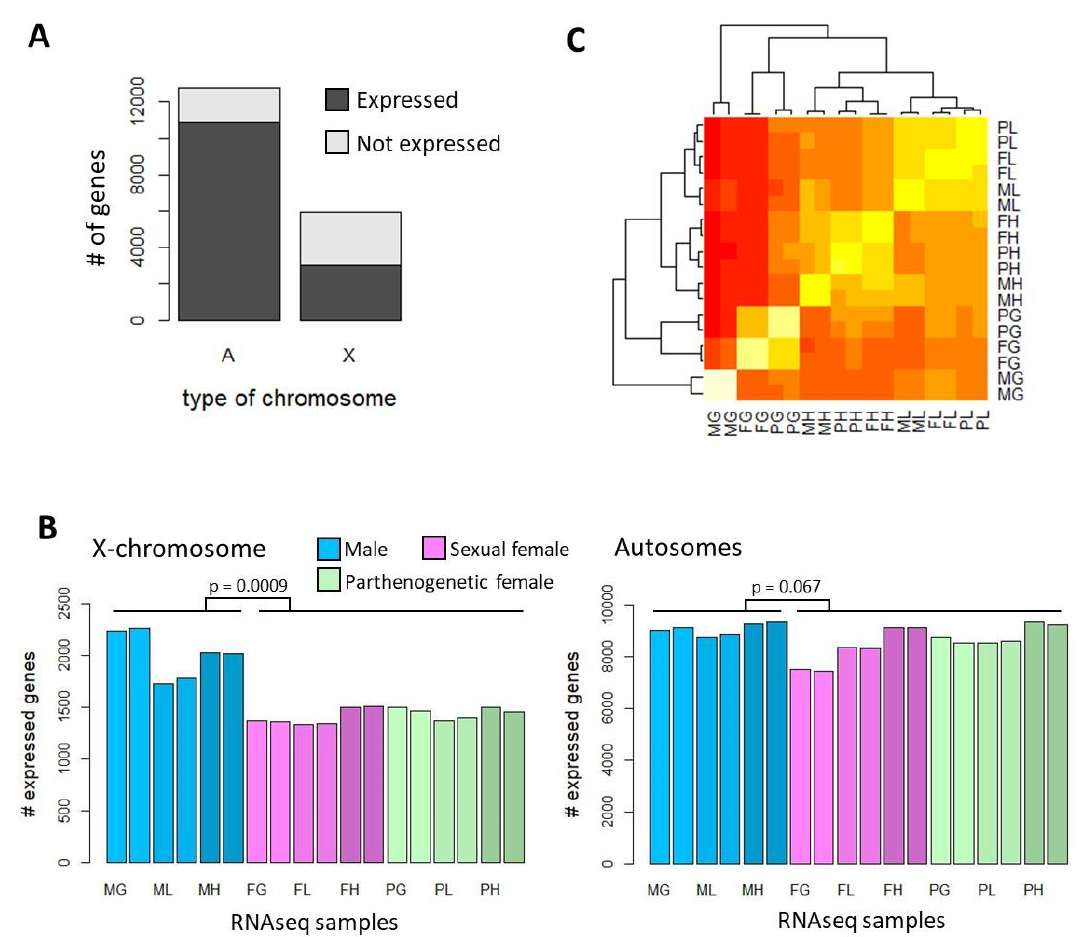
Figure 1: Gene expression in the 18 different RNA-seq samples. A) Number of genes considered as expressed (CPM>1 in at least two samples) and not expressed on the X and on the autosomes. B) Number of expressed genes per sample (expressed at more than 1 CPM) for X-linked and autosomal genes (significance of differences between the X and autosomes was estimated with two-sided Mann-Whitney tests). C) Heatmap of log(CPM+1). Samples group by tissue for head (H) and leg (L) samples, with the parthenogenetic (P) and sexual female (F) samples being always more similar compared to the male samples (M). Expression patterns of male gonad samples (MG) are the most divergent. MG: male gonad, MH: male head, ML: male leg, FG: sexual female gonad, FH: sexual female head, FL: sexual female leg, PG: parthenogenetic female gonad, PH: parthenogenetic female head, PL: parthenogenetic female